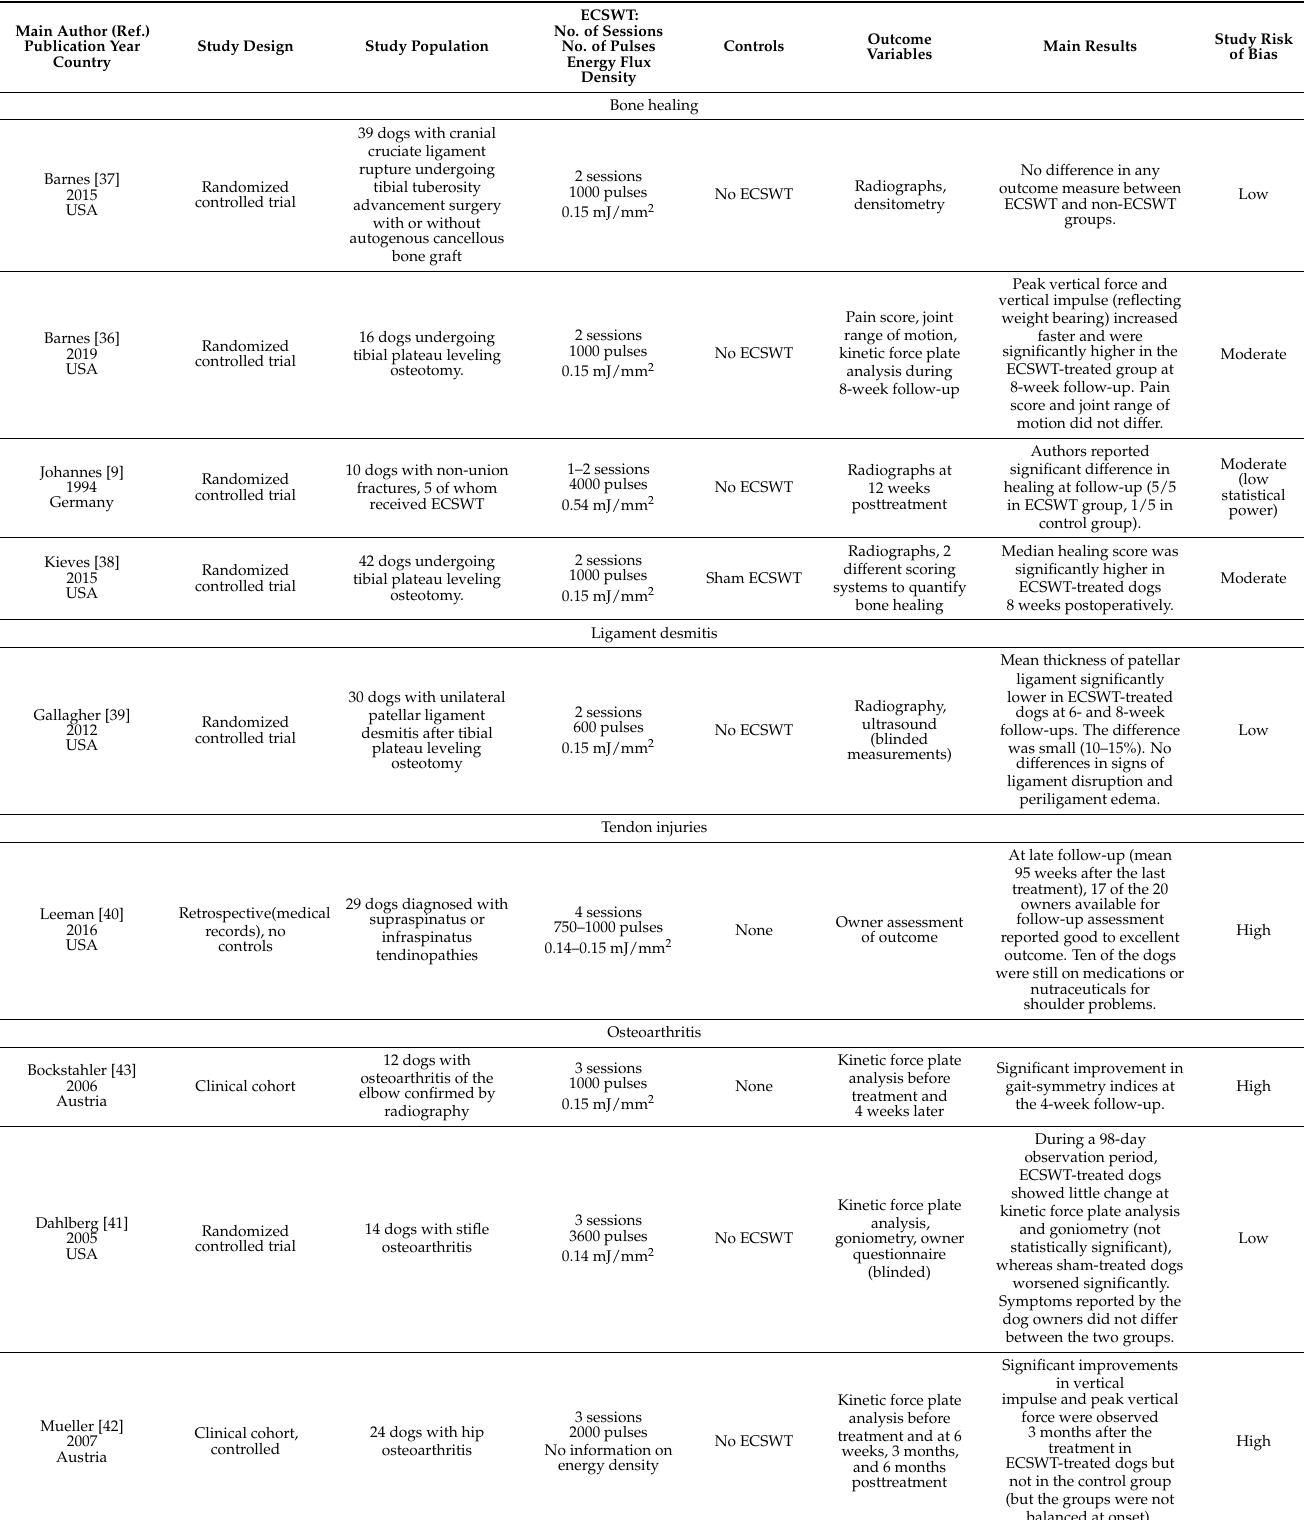
Table 2. ECSWT in dogs: Characteristics of studies included in the systematic